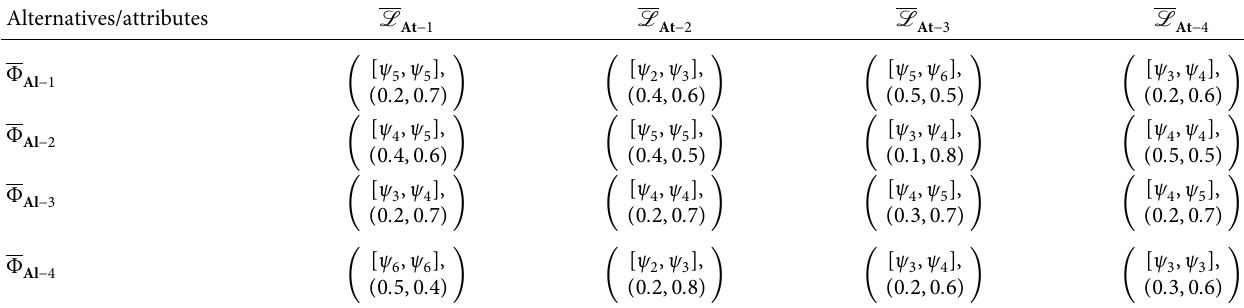
Table 11: Decision matrix provided by expert � R 1 in terms of CIULNs.